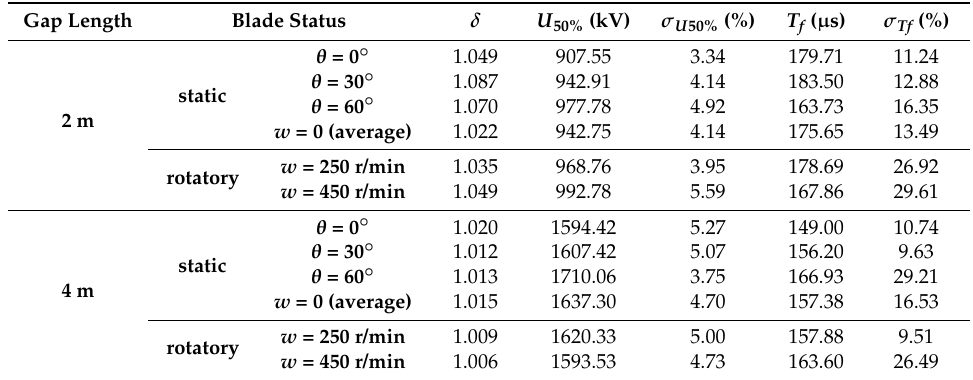
Table 2. Breakdown characteristic of wind turbine.